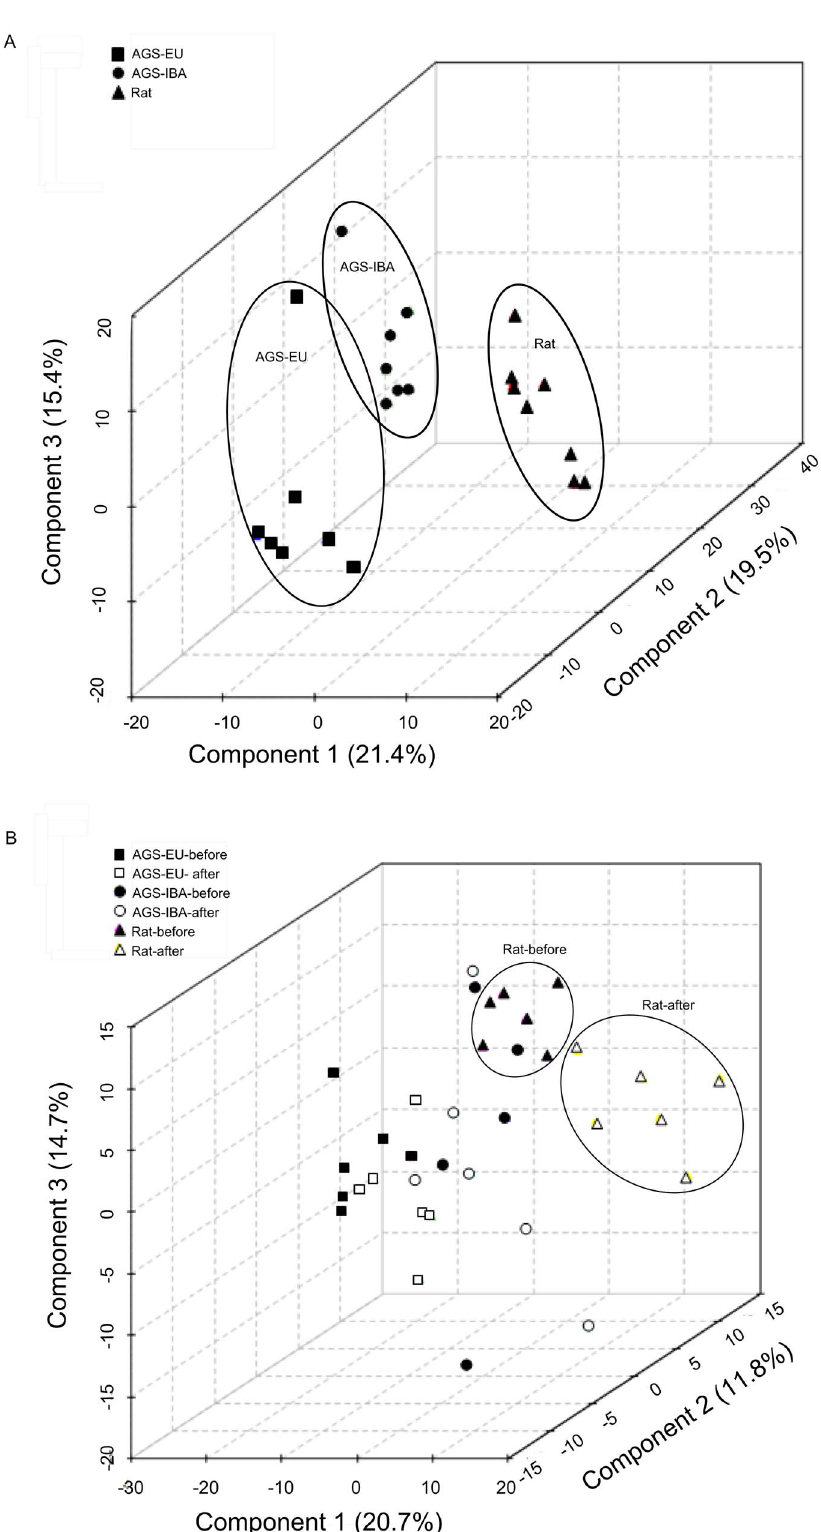
Figure 1. Hydrophilic metabolic profiles. A: Hydrophilic metabolic profiles for naı¨ve summer euthermic and winter IBA-AGS tended to form distinct clusters separate from each other and the naı¨ve rats. However, there was no statistically significant discrimination between the classes (R 2 =1.00, Q 2 =0.79, permutation p=0.70) B: I/R injury–prone rats displayed different hydrophilic metabolic profiles before and three hours after hemorrhagic shock (R 2 =0.95, Q 2 =0.79, permutation p , 0.01.). No such clustering was evident for the AGS in either hibernation season. PLS-DA analysis of 1 H – NMR of naı¨ve plasma samples (A) or samples from before and after hemorrhagic shock (B).